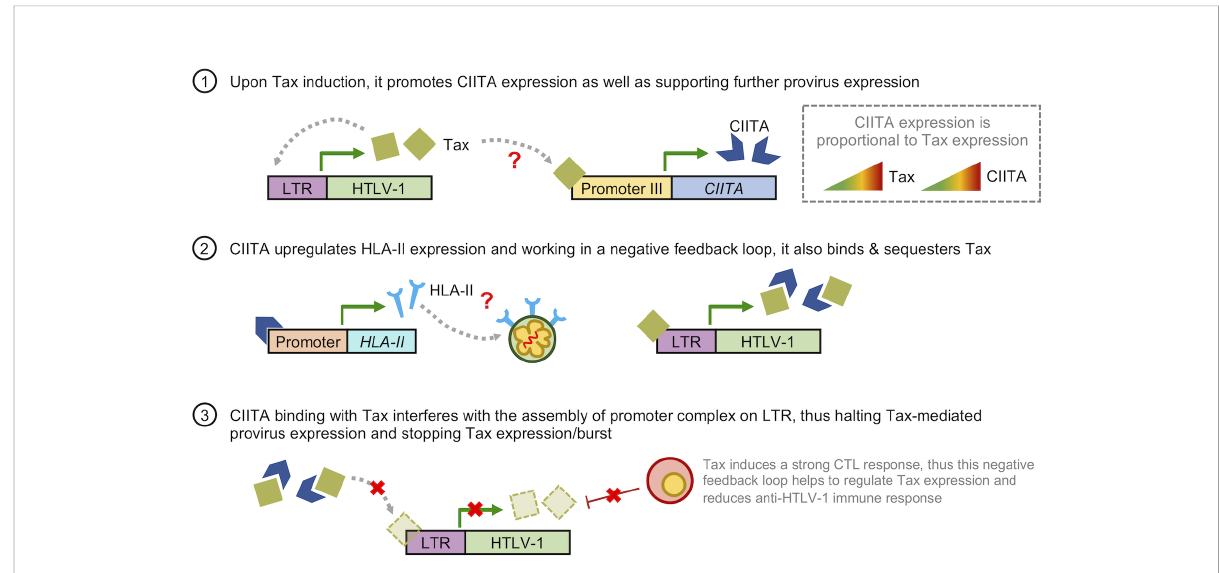
FIGURE 4 Hypothetical model on how HTLV-1 hijacks the CIITA-HLA-II axis for immune evasion. (1) Upon induction of Tax either during initial infection or a Tax burst, it promotes CIITA expression as well as further supporting HTLV-1 provirus expression in a positive feedback loop. As the level of Tax increases, so does the levels of CIITA. (2) CIITA induces expression of HLA-II-related genes, leading to upregulation of HLA-II molecules on the cell surface of HTLV- 1-infected and ATL cells. This confers an immunosuppressive phenotype to these cells. Additionally, CIITA also binds and sequesters Tax. (3) Working in a negative feedback loop, binding of CIITA and Tax reduces the amount of Tax available for the assembly of promoter complex on the LTR, leading to a reduction in Tax-mediated expression of the HTLV-1 provirus, thus halting Tax expression or burst. Additionally, this also reduces the amount of Tax available for antigen presentation to Tax-speci fi c CTLs, thus reducing CTL activity against HTLV-1. The red question marks in (1) and (2) indicates the points in which the regulation of CIITA in HTLV-1 infection is still unclear; namely (1) how Tax interacts with the promoter of CIITA, and (2) how CIITA and HLA-II expression is maintained throughout the latent